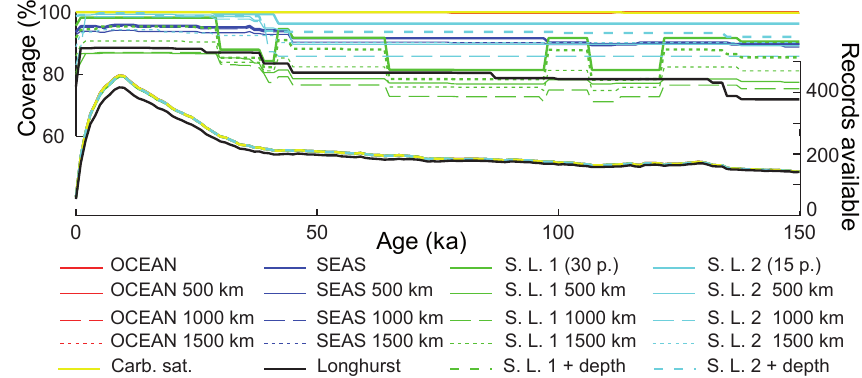
Figure 3. Coverage and number of records used for each province map. Coverage is calculated by summing the modern burial rates in each province (Fig. A1) for which at least one sedimentary record is available, divided by the modern burial flux. The modern map used corresponds to Fig. 2a.